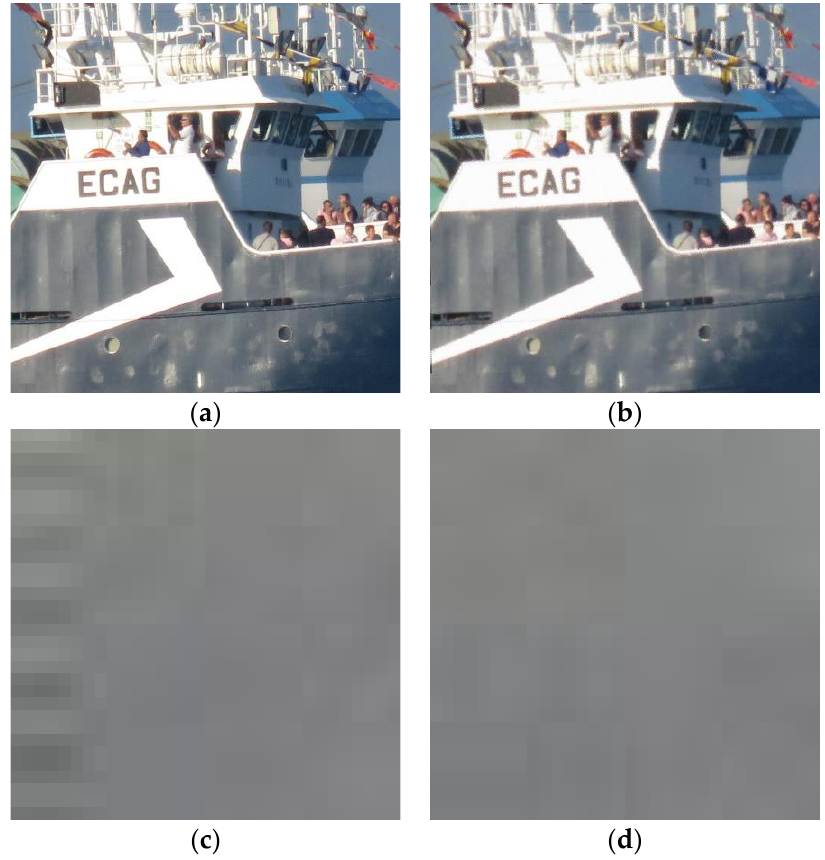
Figure 5. ROI (1024 × 1024) of the original image of Figure 2 ( a ); image processed with method H ( b ); corner artefacts corrected with different methods ( c , d ).